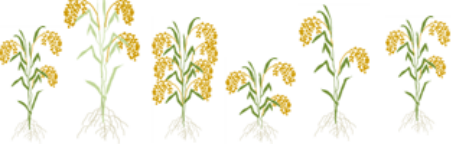
Figure 4. A mutant population was generated with the use of gamma or X-ray at different doses covering the range between 75 and 600 Gy plus a 0 Gy control. Plants were grown in glasshouse conditions with a hydroponic system. Single panicle descent was used for maintenance of mutant lines and for subsequent mutant selection.